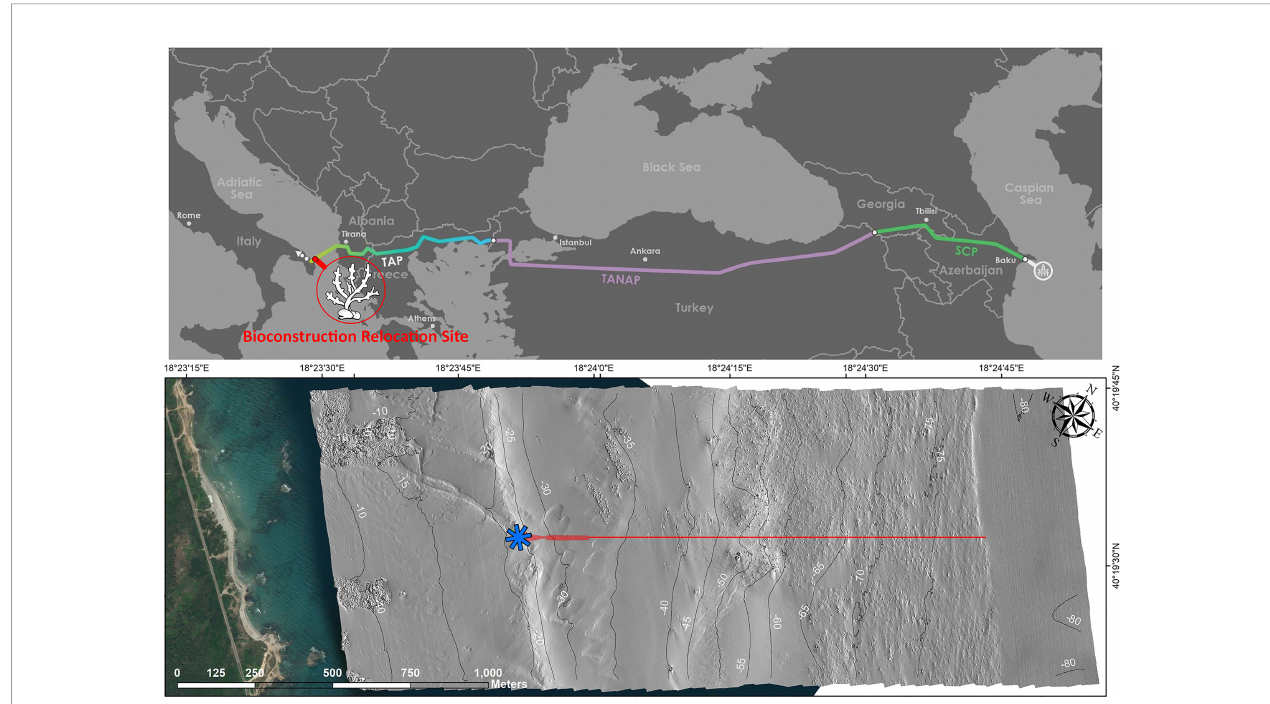
FIGURE 1 | The upper fi gure shows the whole route of the Southern Gas Corridor with the TAP, TANAP and SCP segments highlighted in yellow-blue, violet, and green respectively (modi fi ed from https://www.tap-ag.com/), and the location of the intervention site. The lower map shows the shallower TAP section along the Italian coast: the pipeline entry point in the microtunnel is indicated by a blue asterisk, the pipeline ’ s footprint is highlighted in red. The seabed morphology up to 80 m depth has been obtained through MBES